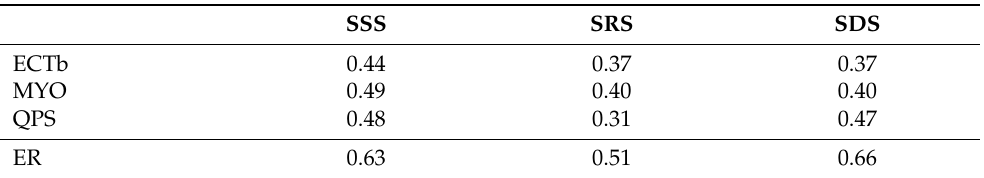
Table 5. Spearman correlation coefficients of the angiographic score with expert estimations and software-derived SSS, SRS and SDS. SSS SRS SDS ECTb 0.44 0.37 0.37 MYO 0.49 0.40 0.40 QPS 0.48 0.31 0.47 ER 0.63 0.51